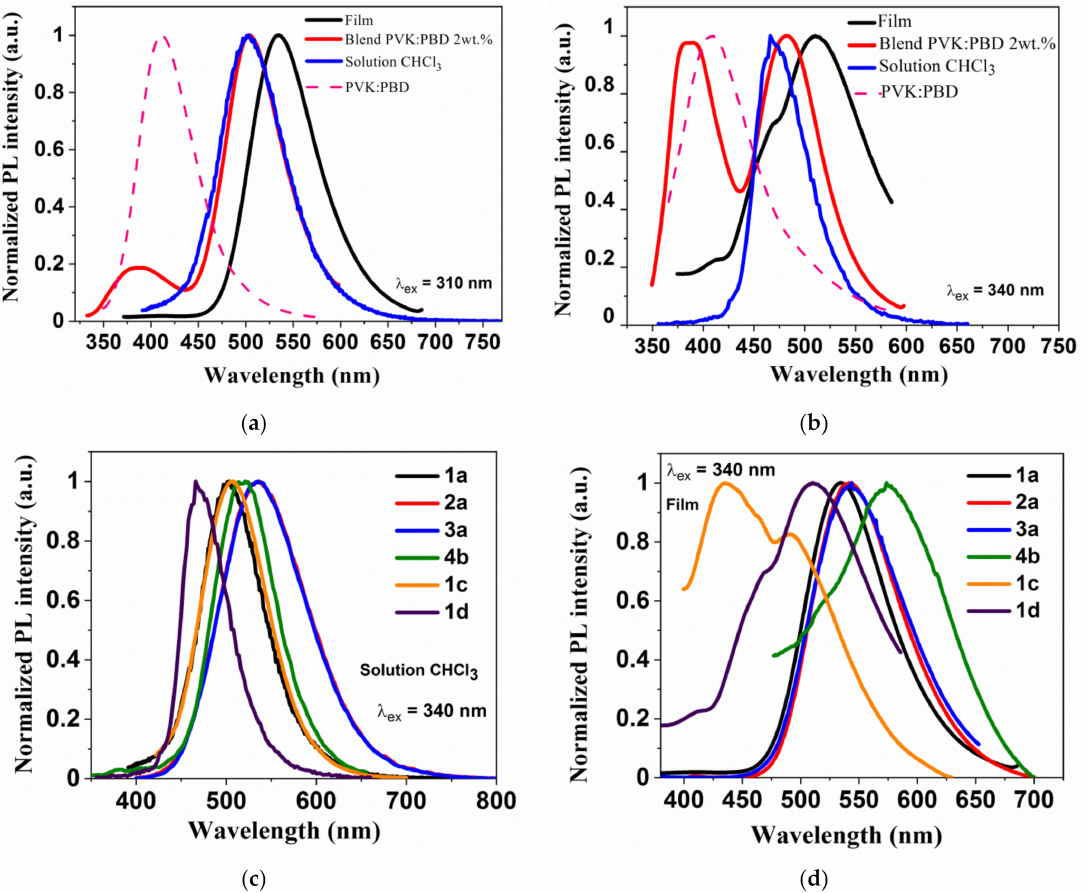
Figure 5. Emission spectra (PL) ( a ) of 1a; ( b ) 1d; ( c ) in chloroform solution and in ( d ) the films of bis-(imino-1,8- naphthalimide)